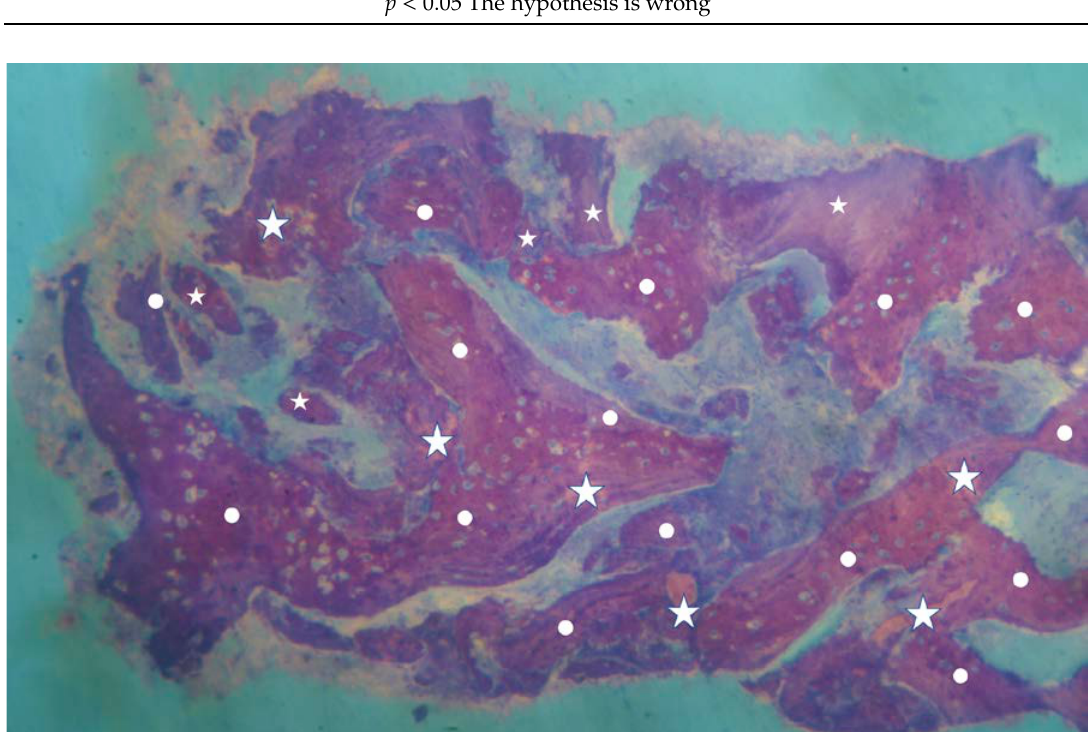
Figure 1. Overview of a biopsy at low magnification. Group 1: dentin matrix granules (indicated by white stars) originating from whole tooth completely surrounded by newly formed bone (indicated by white circles) are visible. No inflammatory or other adverse reaction is visible around the particles (magnification 8×; toluidine blue).